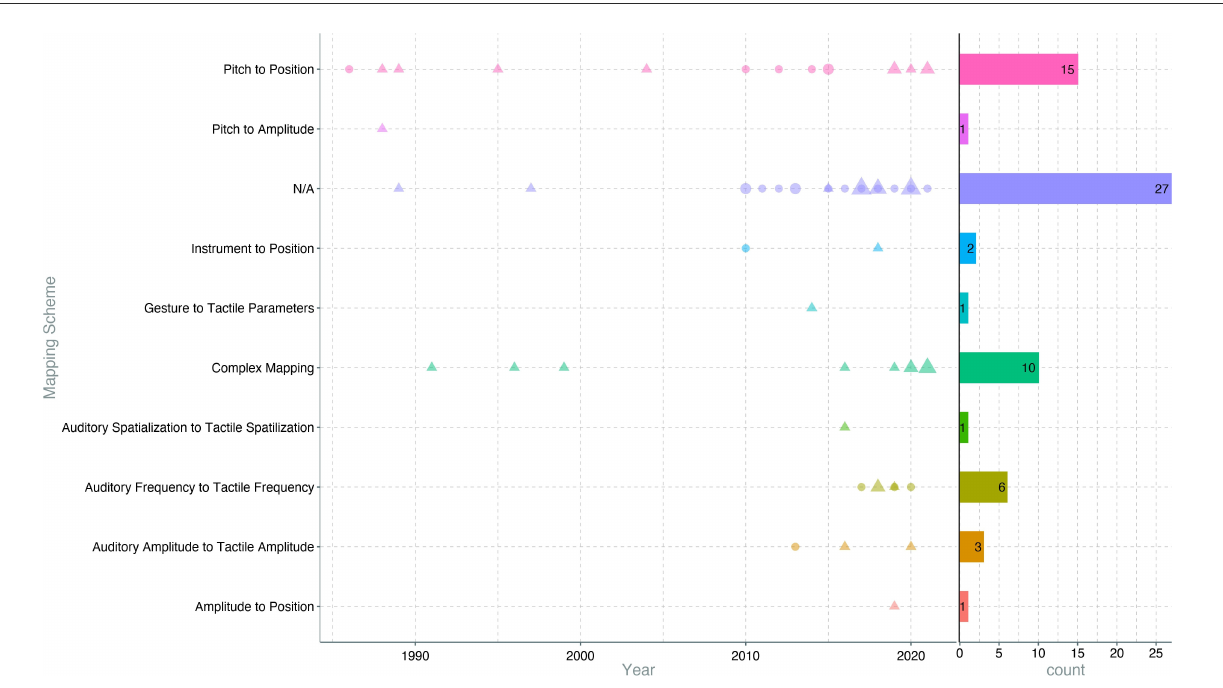
FIGURE5 Distribution of mapping schemes used over time; a triangle indicate a wearable device, a circle indicates a fixed device and the size of the shape represents the amount of similar devices.